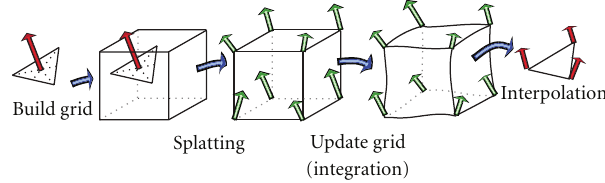
Figure 3: Particle mesh approximation algorithm to transform the computation from irregular domain to regular domain based on four basic steps: grid construction, splatting, integration, and